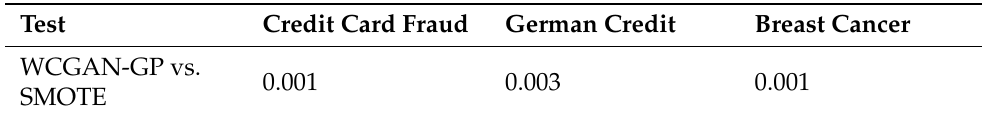
Table 10. Results for the post-hoc